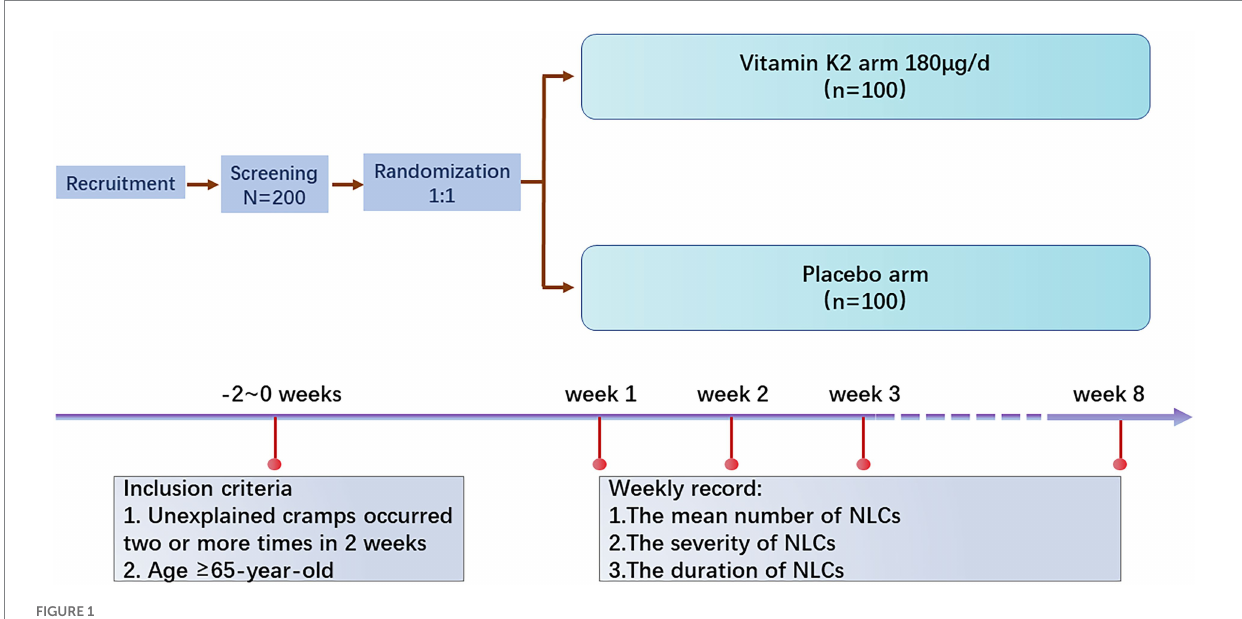
FIGURE 1 Study design and flow